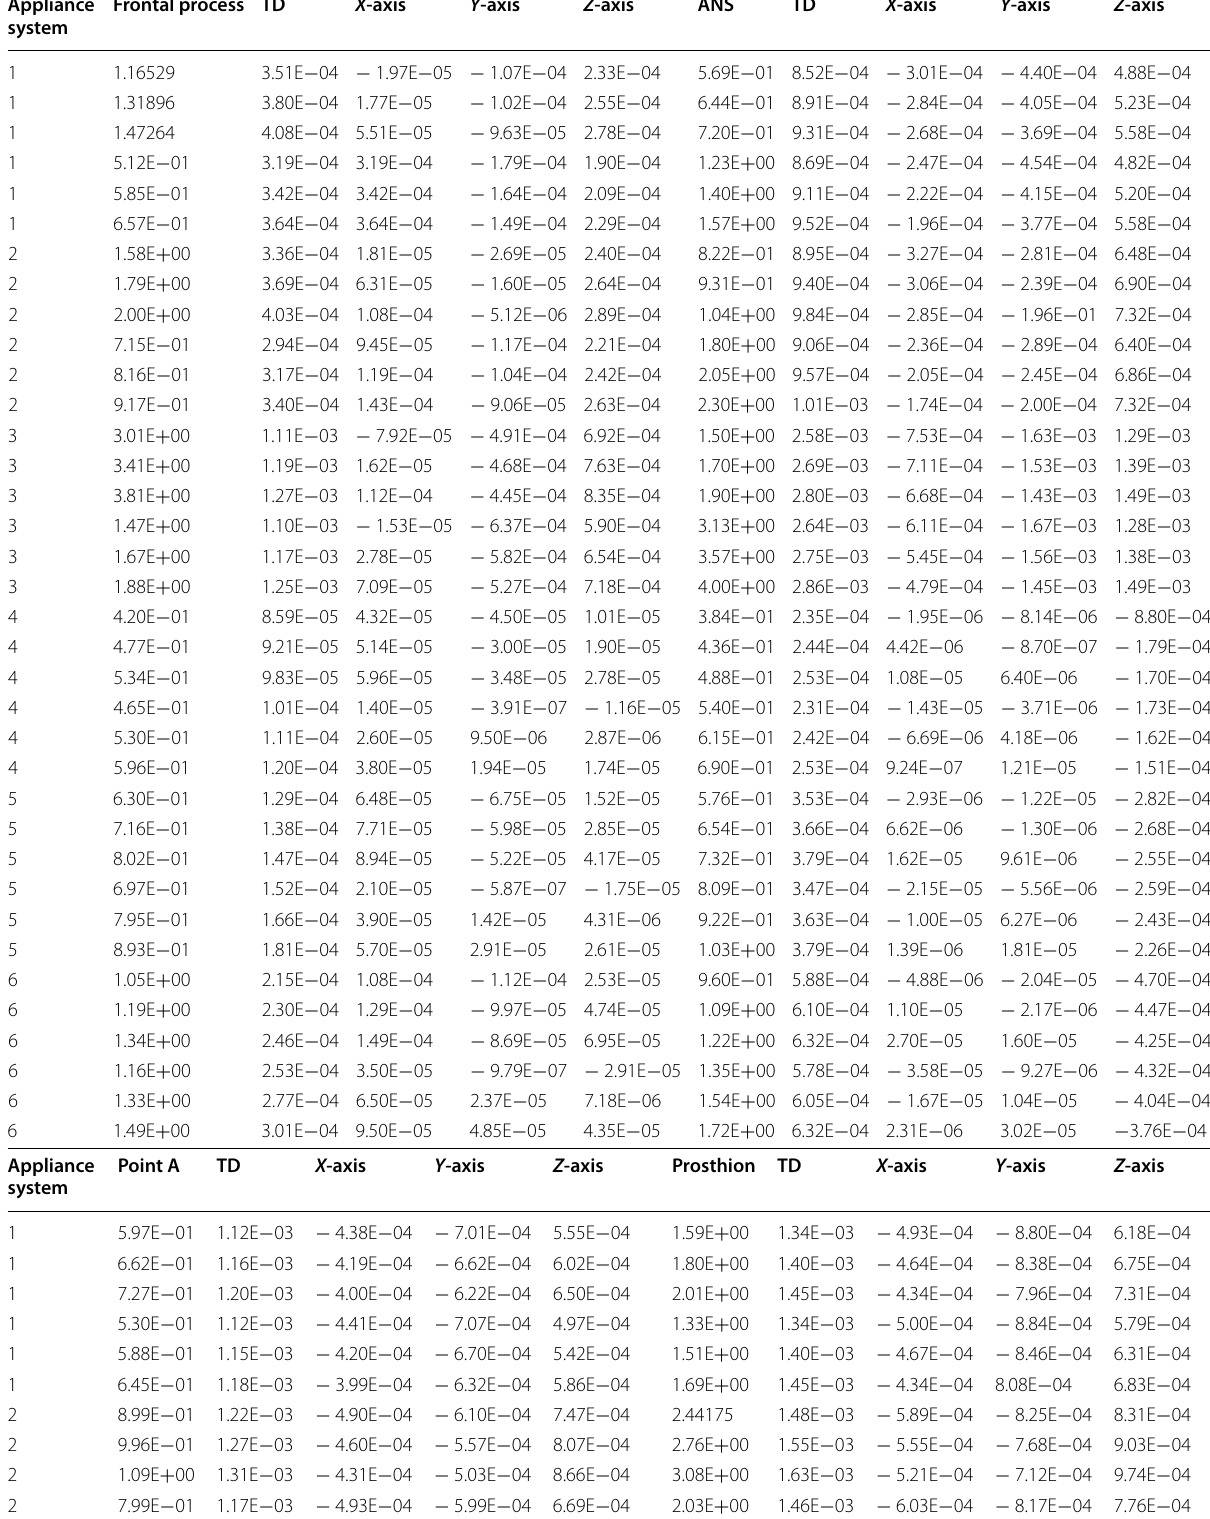
Table 3 Stress distribution and displacement in anatomical